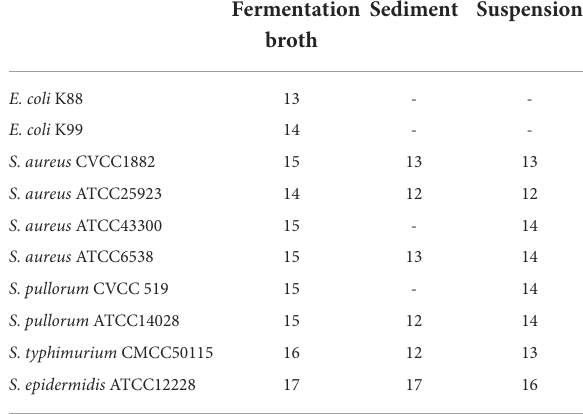
TABLE 1 The diameter of the inhibition zone of B. subtilis M6 against pathogenic bacteria. Indicator species